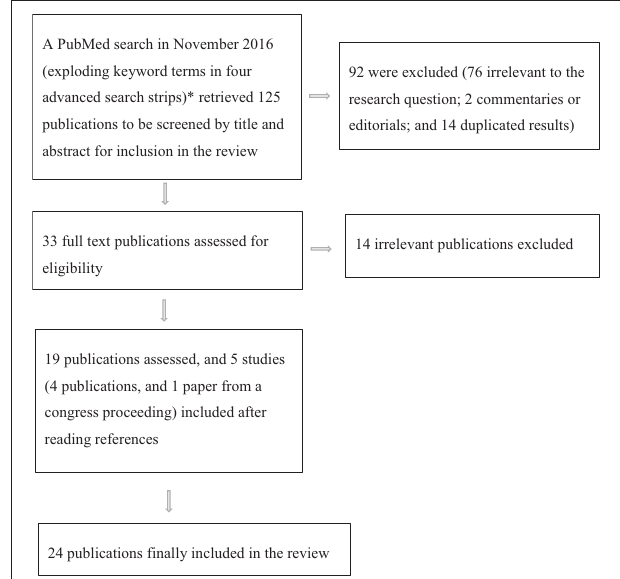
FIGURE 1 | A flow chart showing multiple search strategies and reasons for excluding and including publications in the review. *Four search strategies (November 2016): (((phage) OR bacteriophage) AND cystic fibrosis) AND Pseudomonas aeruginosa [TI] (92 publications); ((((phage therapy) AND bacteriophage therapy)) AND Pseudomonas aeruginosa ) AND cystic fibrosis [TI] (16 publications); ((cystic fibrosis) AND ((phage therapy) AND bacteriophage therapy)) AND Pseudomonas aeruginosa biofilm [TI] (6 publications); and ((((phage therapy) AND bacteriophage therapy)) AND Pseudomonas aeruginosa ) AND phage resistant* (11